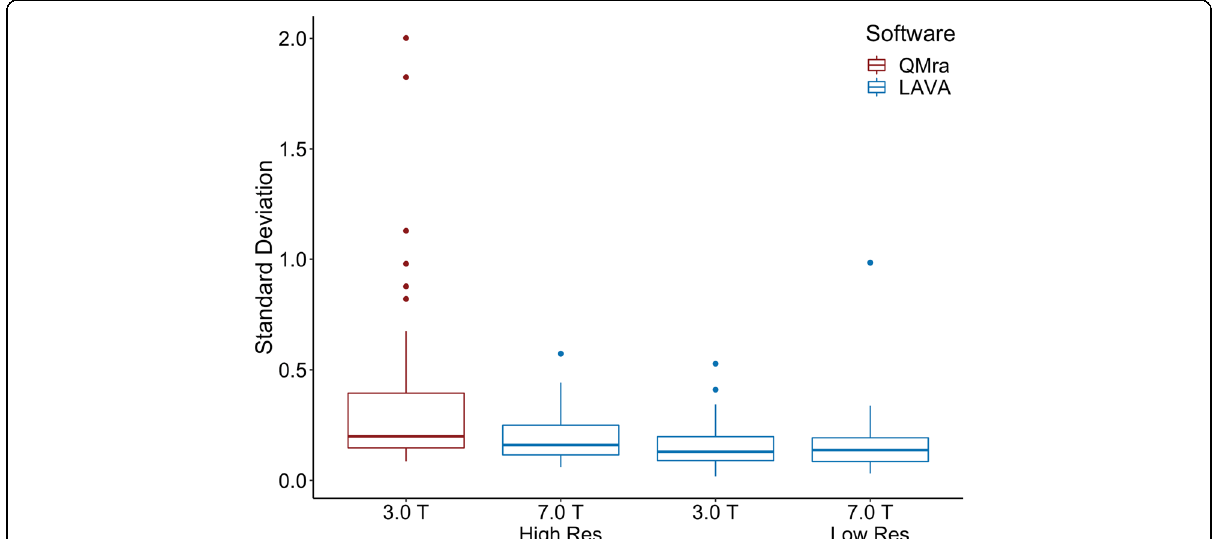
Fig. 1 Standard deviations of the intradural MMA measurements in the four analysis iterations. 7.0 T High Res: 7.0 T scan at full resolution; 7.0 T Low Res: 7.0 T scan resampled to 3.0 T